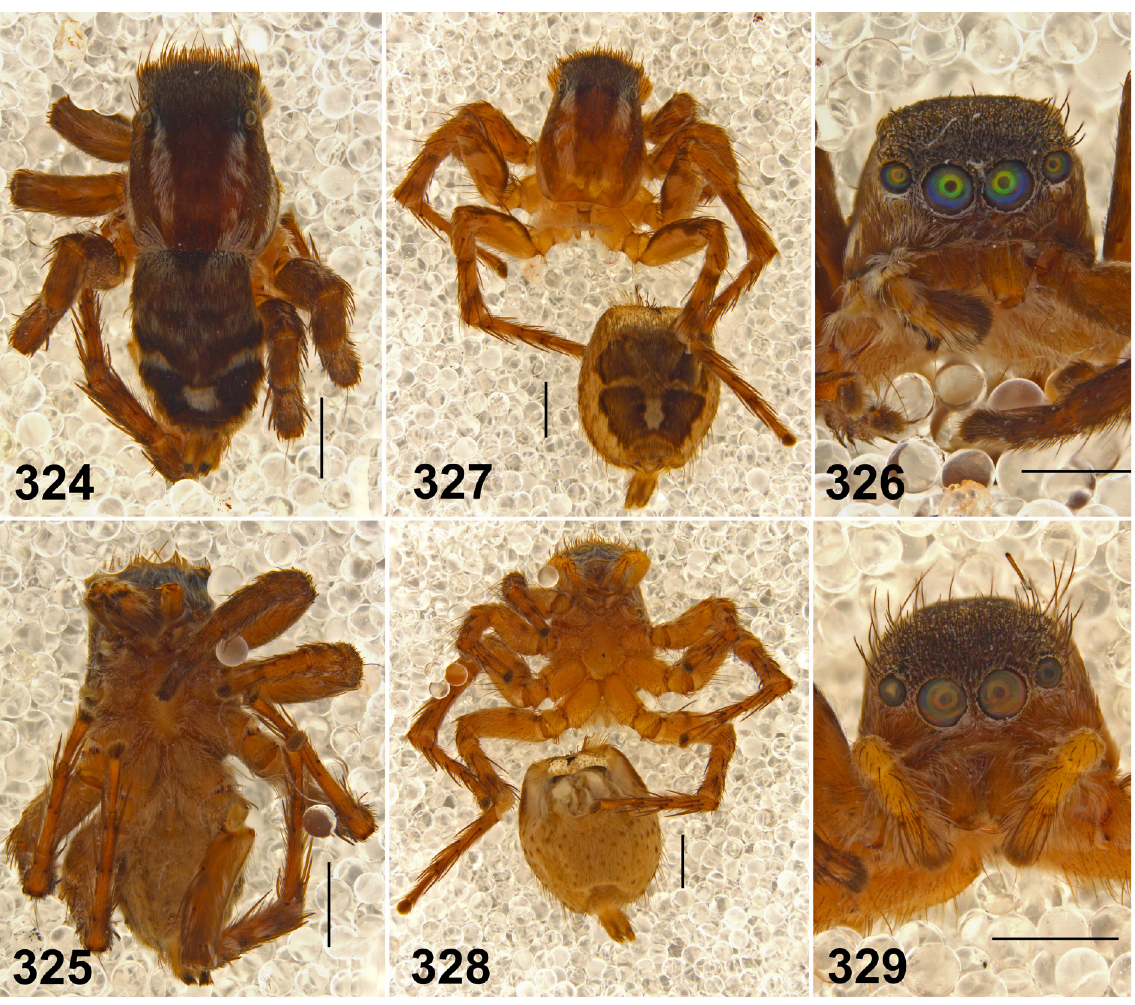
Figs 324–329. Stenaelurillus kronestedti Próchniewicz & Heçiak, 1994, general appearance. 324– 326 . Holotype. 327–329 . Paratype, ♀. Scale bars: 1